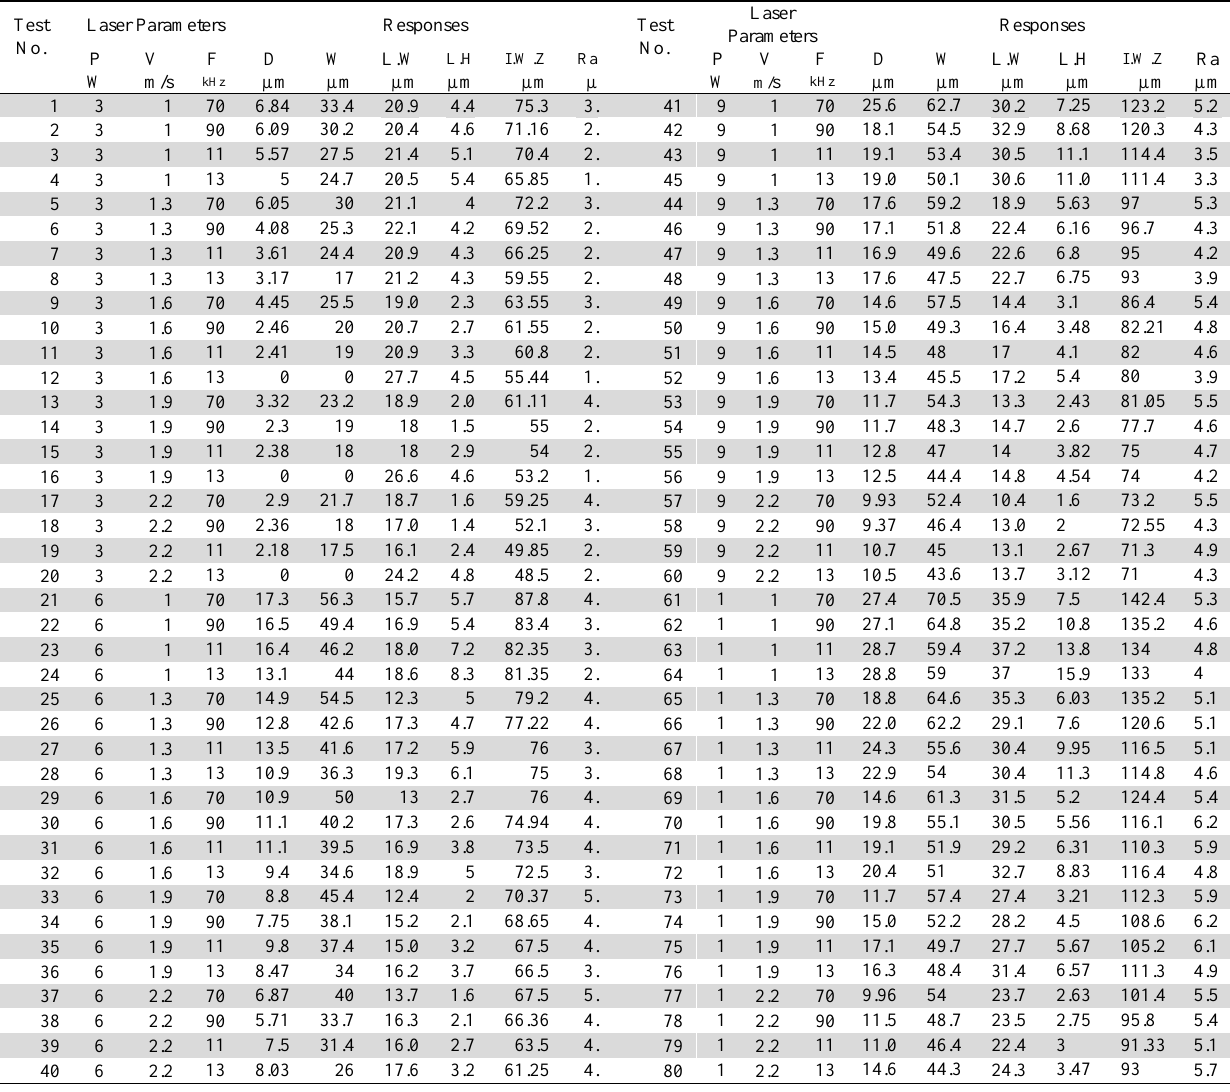
The LDS inputs parameters and the experimental measurements for the LDS outputs Test Laser No.